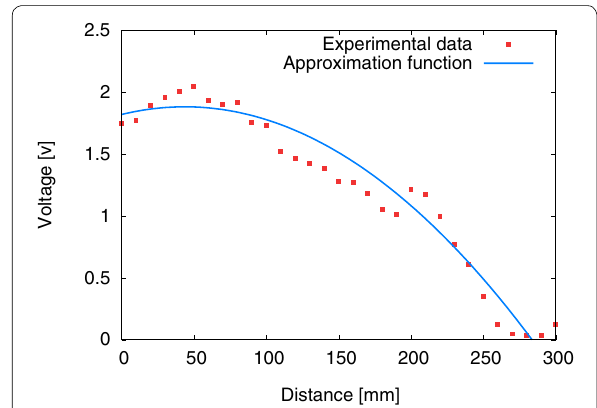
Fig. 6 Experimental data recorded when measuring the value of the voltage of the receiver as a function of the change in the distance between the emitter and the receiver in the horizontal plane (red points) and the approximation function obtained by the least-squares method (blue